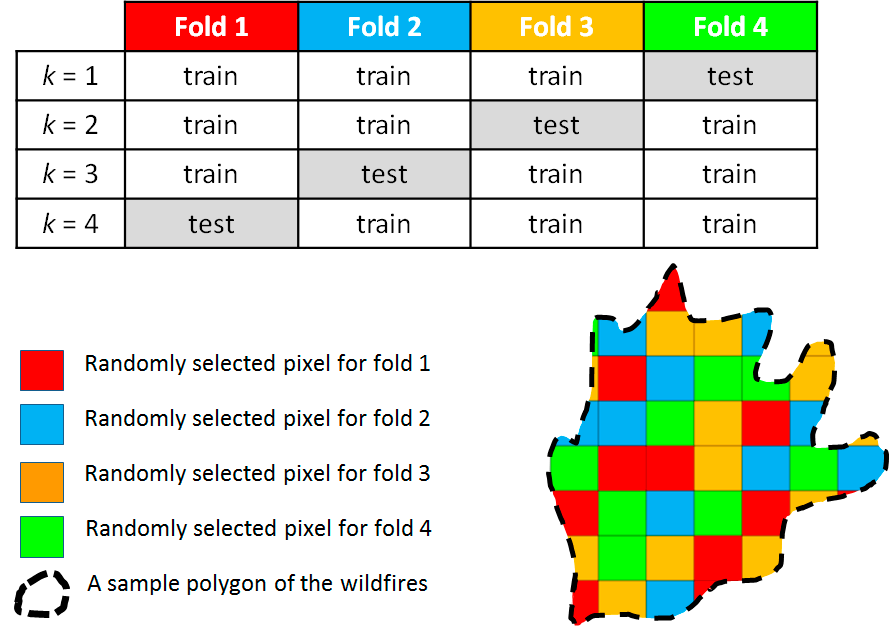
Figure 2. The description of applied four-fold cross-validation (CV) for the inventory